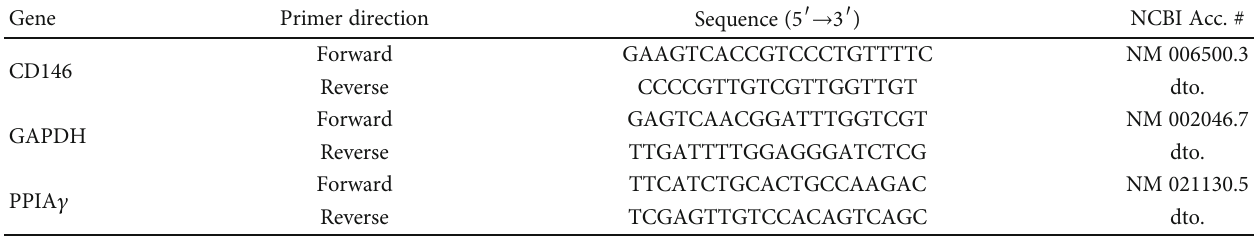
Table 2: Primers for qRT-PCR.